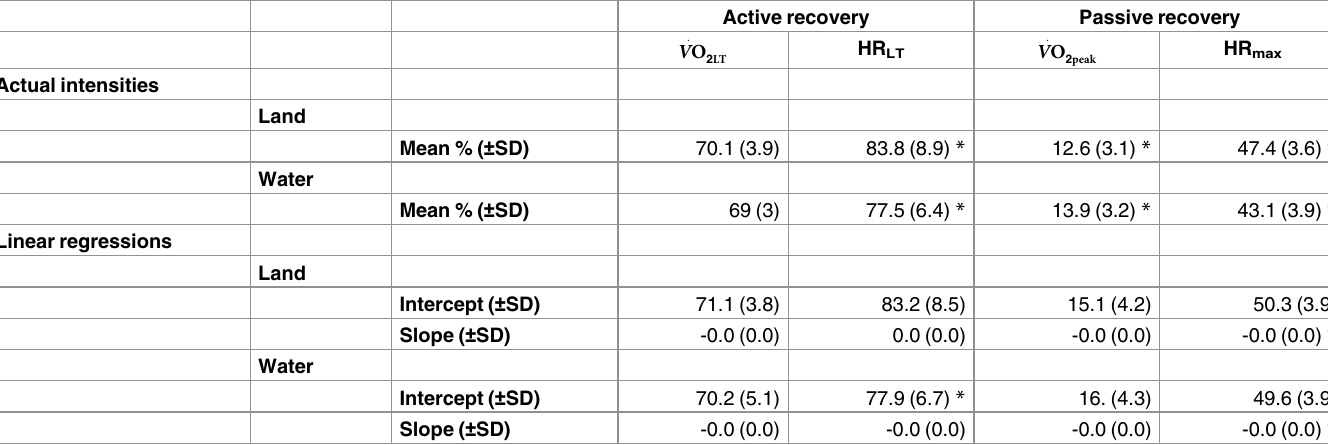
Table 2. Comparisons of the recovery intensity between land- and water-based clearanceconditions for both active and passive recoverymodes.